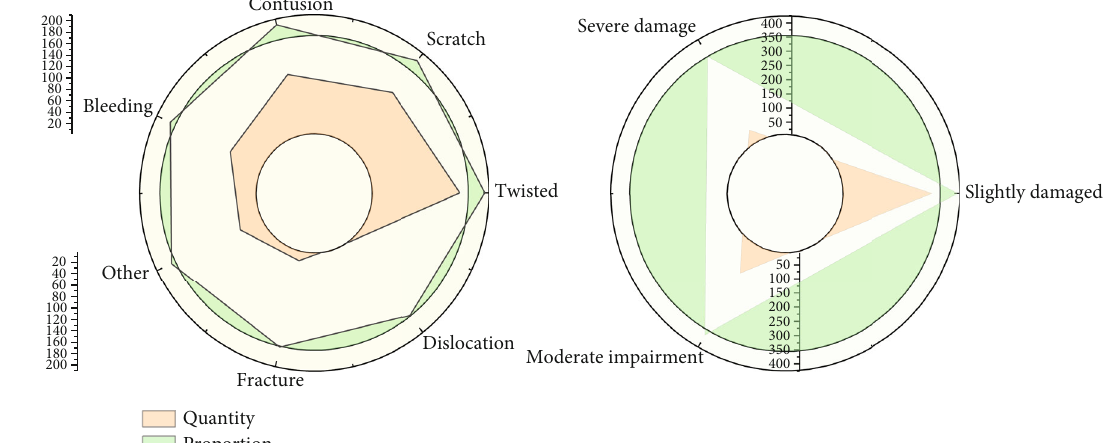
Figure 4: Statistical chart of injury type and degree of sanda athletes.